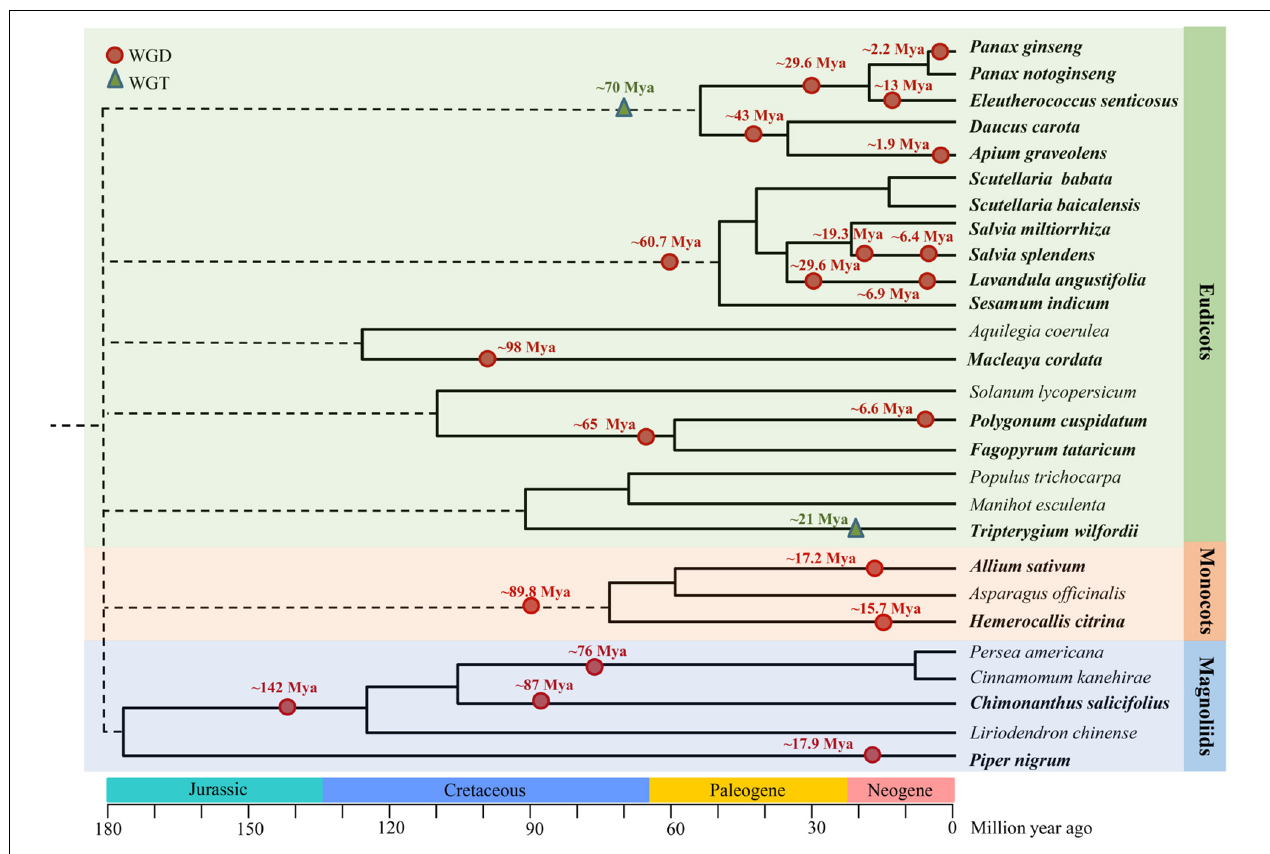
FIGURE 5 | The whole genome duplication (WGD) and whole genome triplication (WGT) events in representative medicinal